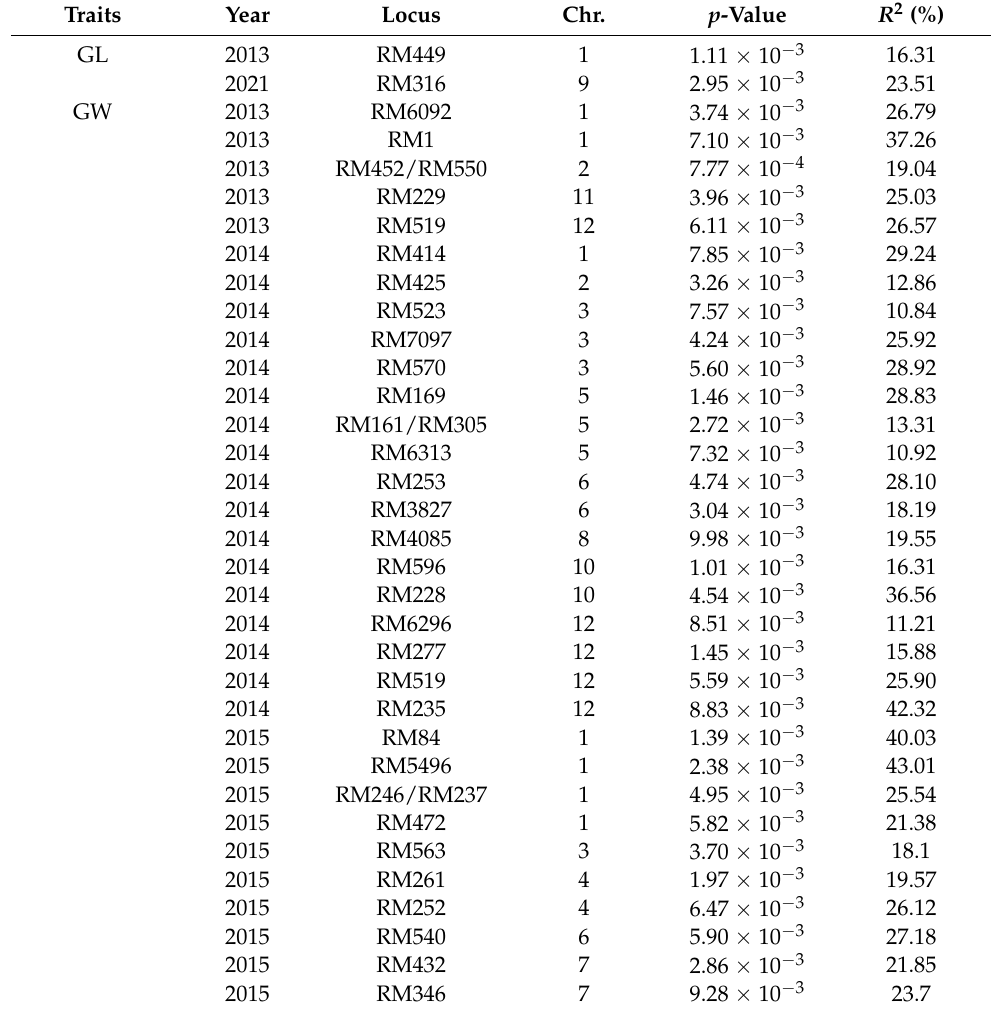
Table 3. SSR markers significantly associated with five grain traits in four years.